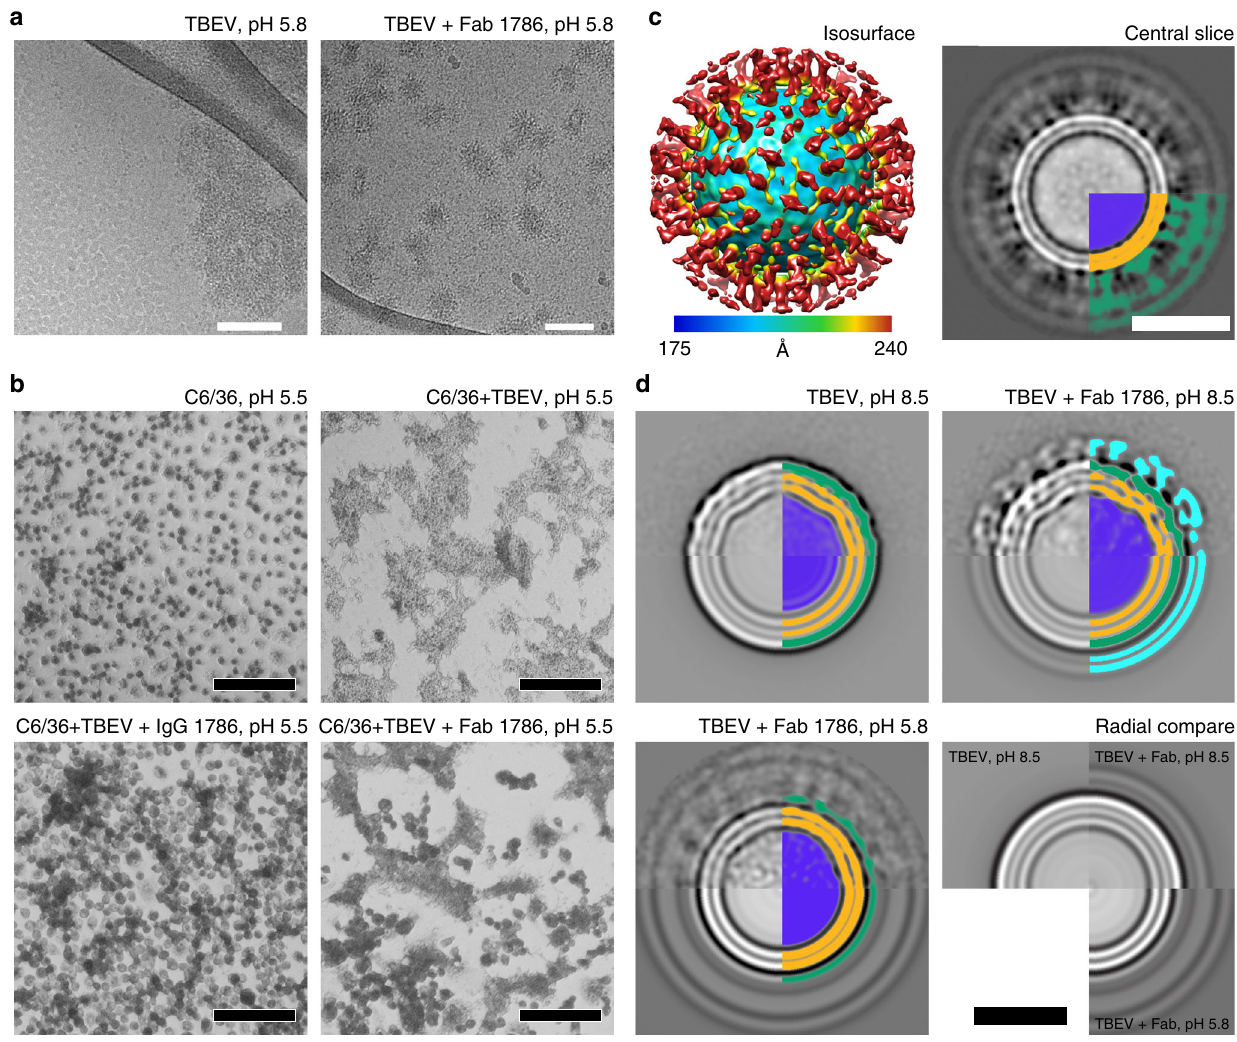
Fig. 5 TBEV virions and TBEV – Fab 19/1786 complex in low-pH environment. a Cryo-EM micrographs of TBEV virions fused together under low-pH conditions. However, TBEV virions covered with Fab 19/1786 fragments did not aggregate. Scale bar represents 100 nm. b “ Fusion-from-without ” assay on C6/36 cells. The control cells did not fuse in the low-pH (5.5) environment. In contrast, native TBEV induced complete cell fusion. Pre-incubation of TBEV with IgG 19/1786 completely abolished the fusion activity of the virus and the Fab 19/1786 lowered the fusion activity of the TBEV. The scale bar represents 100 µ m. c Cryo-EM reconstruction of Fab-covered TBEV virion at low pH. The isosurface is radially colored according to the distance from the center. Corresponding central slice perpendicular to the 5-fold axis is shown on the right. The particles lost the compact layer of the E-protein ectodomain and the viral membrane is not deformed by the transmembrane helices. The lower right quadrant of the slice is color-coded as follows: nucleocapsid — blue; inner and outer membrane lea fl ets — orange; M-proteins, E-proteins, and Fab fragments cannot be distinguished and are shown in green. The scale bar represents 25 nm. d Reference-free 2D class averages of TBEV virions in solutions with different pH levels. The upper half of the images shows the class averages, whereas the bottom parts are radial averages of the same classes. In the radial averages, the three distinct layers represent the inner and outer lea fl ets of the membrane (in orange) and the ectodomain of the E-proteins (in green). An additional double layer is visible on the virion covered with Fab fragments (in cyan). The layer corresponding to ectodomains of E-proteins and Fab fragments is more diffuse in the low-pH structure than in the particles at neutral pH. The viral membrane remained fully preserved, but lost the deformities introduced by the transmembrane helices of virus proteins. The 2D class averages are color-coded as follows: nucleocapsid — blue; inner and outer membrane lea fl ets — orange; E-proteins — green; Fab 19/1786 attached to virus surface — cyan. The scale bar represents 25